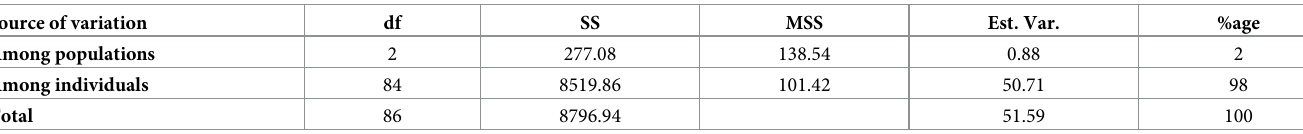
Table 3. Analysis of molecular variance (AMOVA) of Indian mustard cultivars based on SSR data. Source of variation df SS MSS Est. Var. Among populations 2 Among individuals